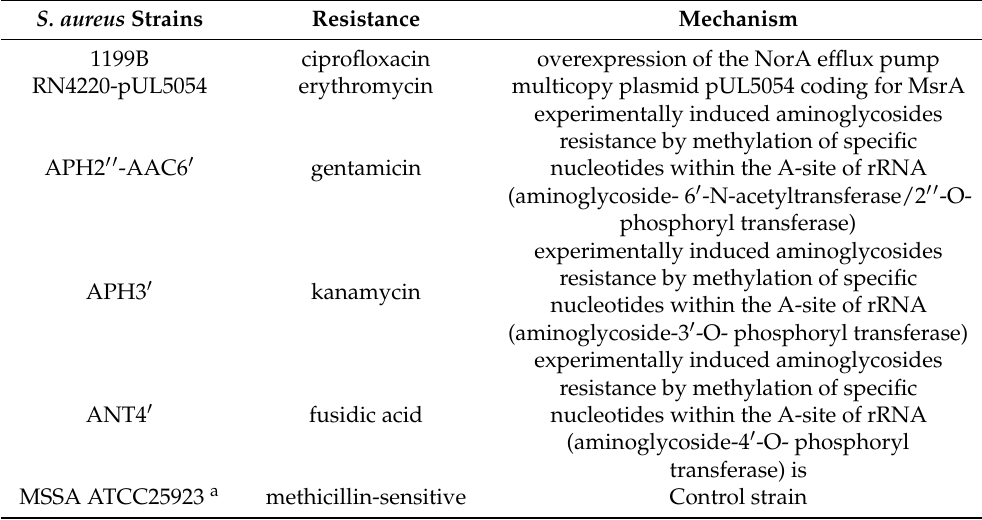
Table 6. The S. aureus strains with known resistance mechanism used in the study. S. aureus Strains Resistance Mechanism 1199B ciprofloxacin overexpression of the NorA efflux pump RN4220-pUL5054 erythromycin multicopy plasmid pUL5054 coding for MsrA experimentally induced aminoglycosides resistance by methylation of specific nucleotides within the A-site of rRNA APH2 (cid:48)(cid:48) -AAC6 (cid:48) gentamicin (aminoglycoside- 6 (cid:48) -N-acetyltransferase/2 (cid:48)(cid:48) -O- phosphoryl transferase) experimentally induced aminoglycosides resistance by methylation of specific APH3 (cid:48) kanamycin nucleotides within the A-site of